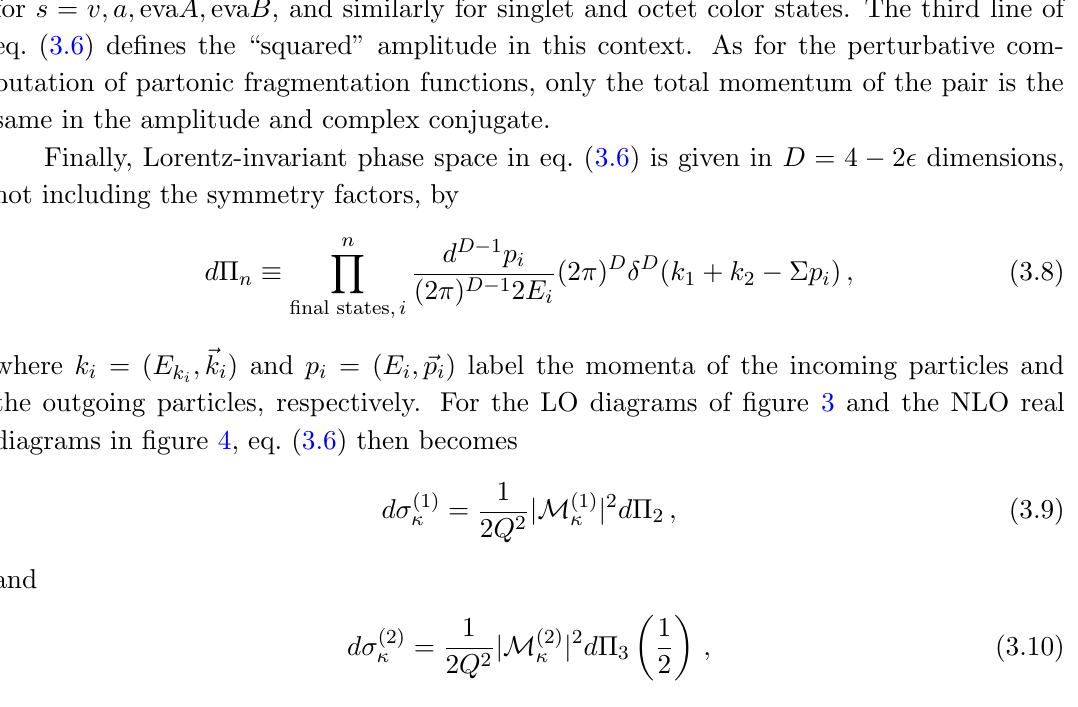
Figure 4 . Four of the eight next-leading order Feynman diagrams for e + e (cid:0) The other four are from (cid:13)ipping the arrows on the fermion lines. Virtual diagrams only contribute to (cid:14) (1 x H ) (cid:0)